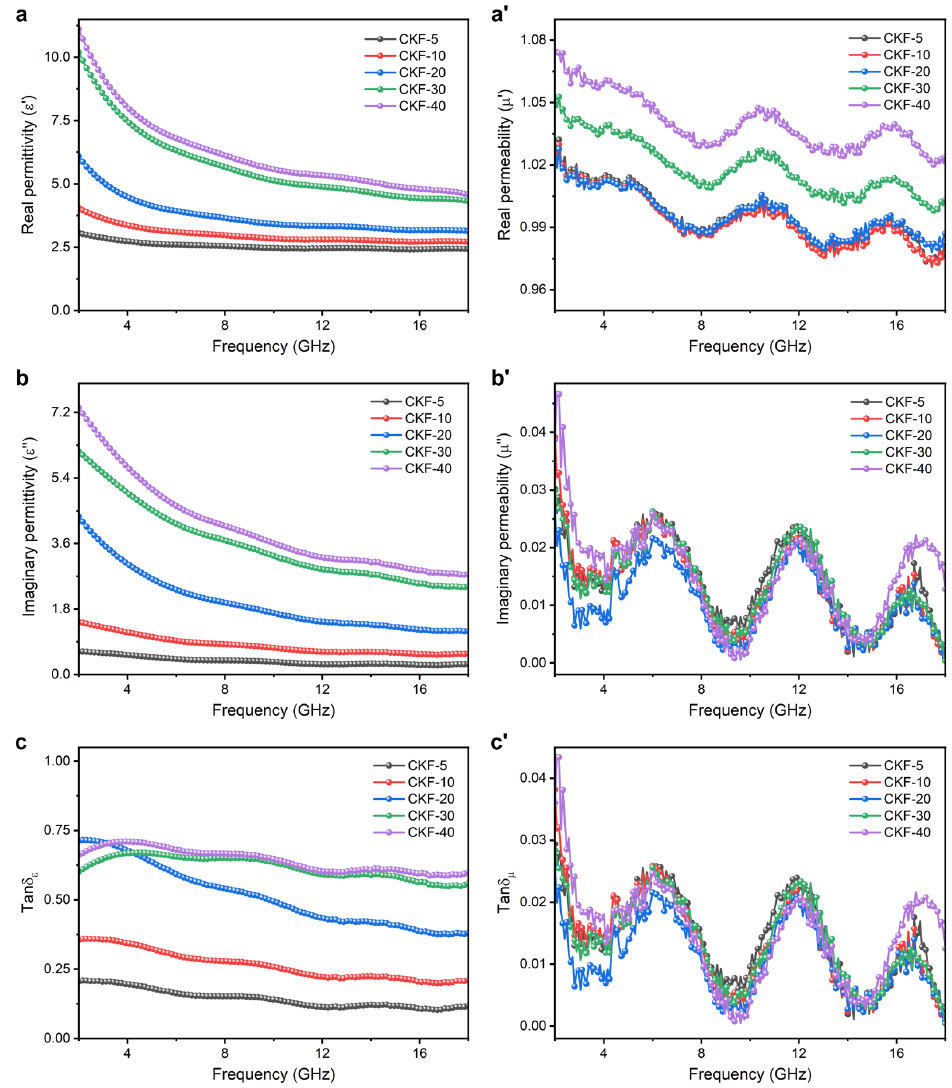
Figure 6. Frequency dependence of electromagnetic parameters of CKF-filled paraffin composites with different filler loading: ( a – c ) complex permittivity and ( a’ – c’ ) complex permeability. Moreover, due to the extensive carbonization-induced defects in CKF and the abun-